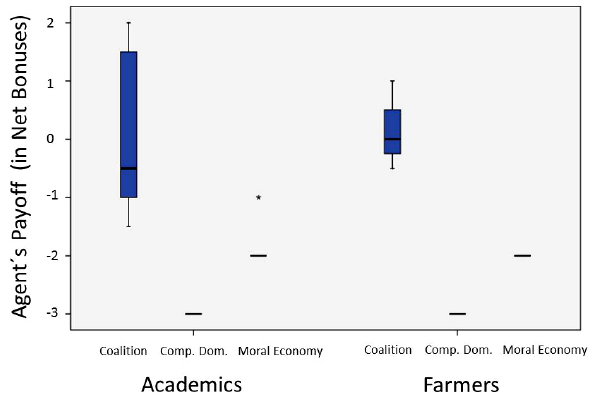
Fig. 6 . Distribution of observed agents’ payoffs in net bonuses (NB) across three social preferences and across two actors, academics and farmers. Net bonuses frequency distributions are compared graphically with box and whiskers quartiles. See X² comparisons in the main